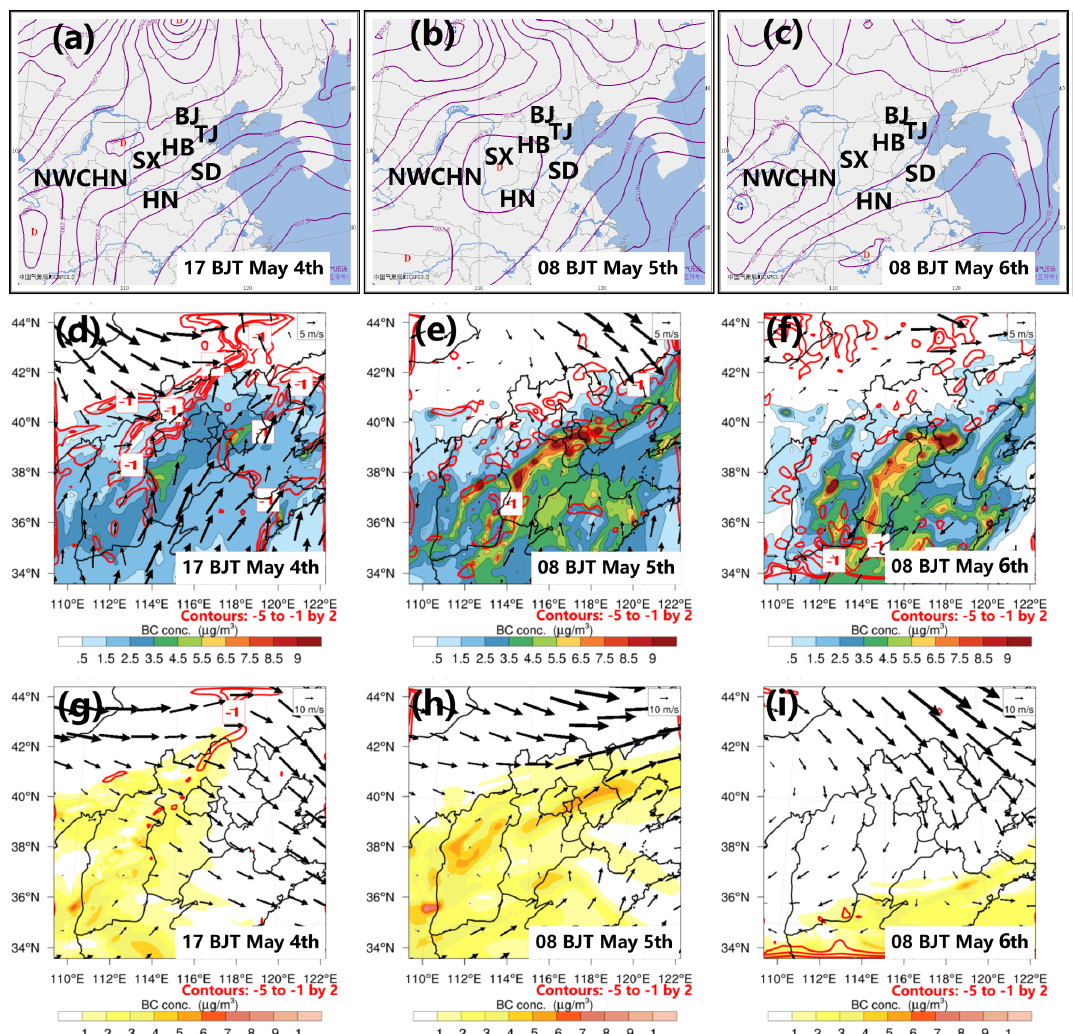
Figure 4. (a–c) Surface synoptic patterns, (d–f) BC concentration and wind vector at the surface, and (g–i) BC concentration and wind vector in the troposphere ( ∼ 4000m) at 17:00BJT on 4 May, 08:00BJT on 5 May, and 08:00BJT on 6 May. The red line represents the convergence region (divergence < 0; unit × 10 − 6 s − 1